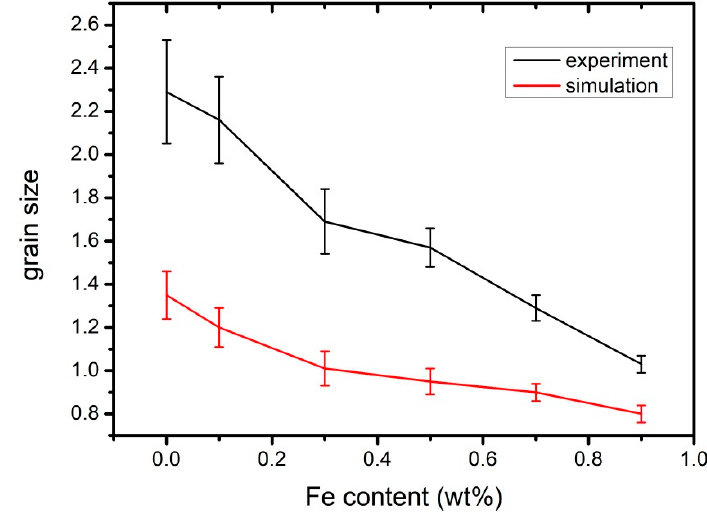
Figure 8. The change in the average grain size with Fe content.